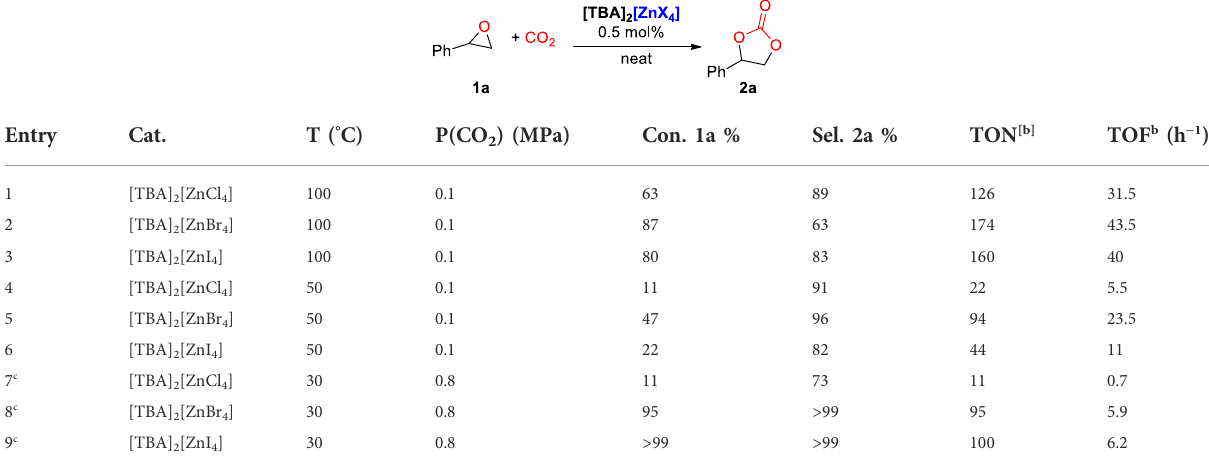
TABLE 3 Cycloaddition of CO 2 to styrene oxide: Effect of the pressure and the temperature a .